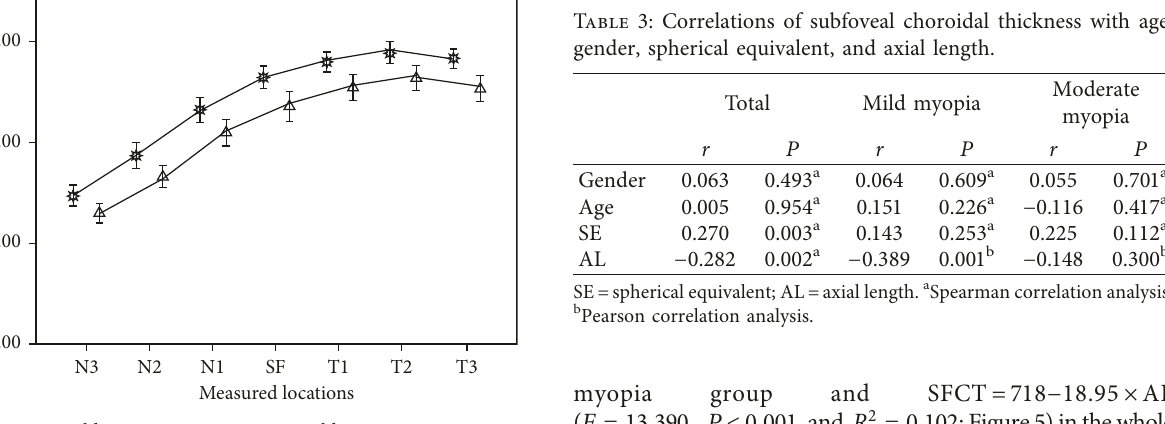
0 . 001 , and R 2 0 . 102; Figure 5) in the whole (cid:31) participant.